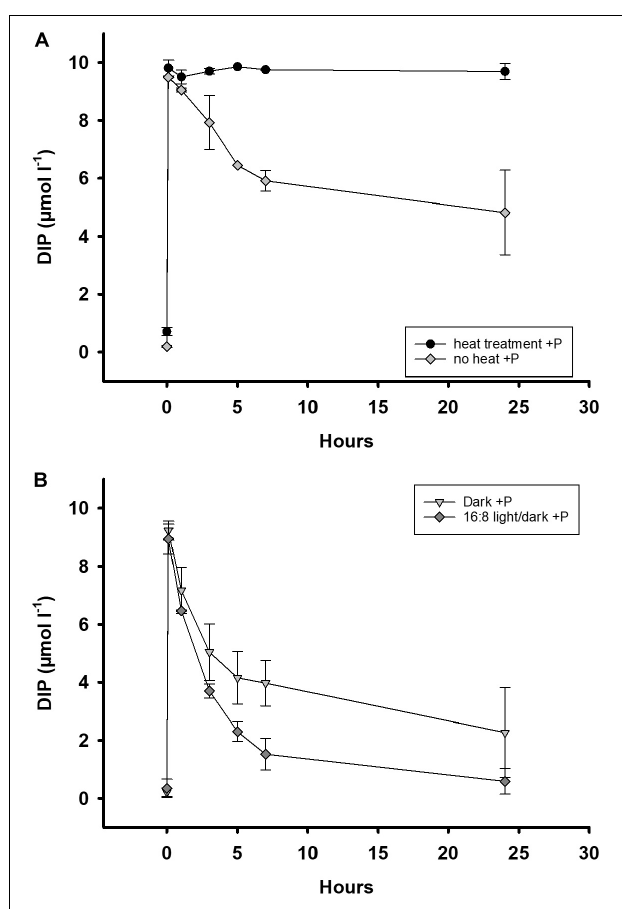
FIGURE 4 | Development of a DIP addition (DIP, 10 µ mol l − 1 ) in batch tanks for 24 h. All samples were from the Zingster Strom. (A) DIP addition to pre-heated (70, ± 2 ◦ C) and unheated batch tanks ( n = 2) for 24 h. Heat treatment was conducted in November 2013 and January 2014. (B) DIP addition to dark incubated ( n = 2) and normally irradiated batch tanks ( n = 2). Dark incubation started 12 h before DIP addition and was conducted in July 2013 and September 2014 ( n = 2). Error bars are calculated as standard deviation. Incubation in batch tanks at 15 ◦ C ( ± 1 ◦ C), photon flux 100 µ mol photons m − 2 s − 1 , light:dark 16:8